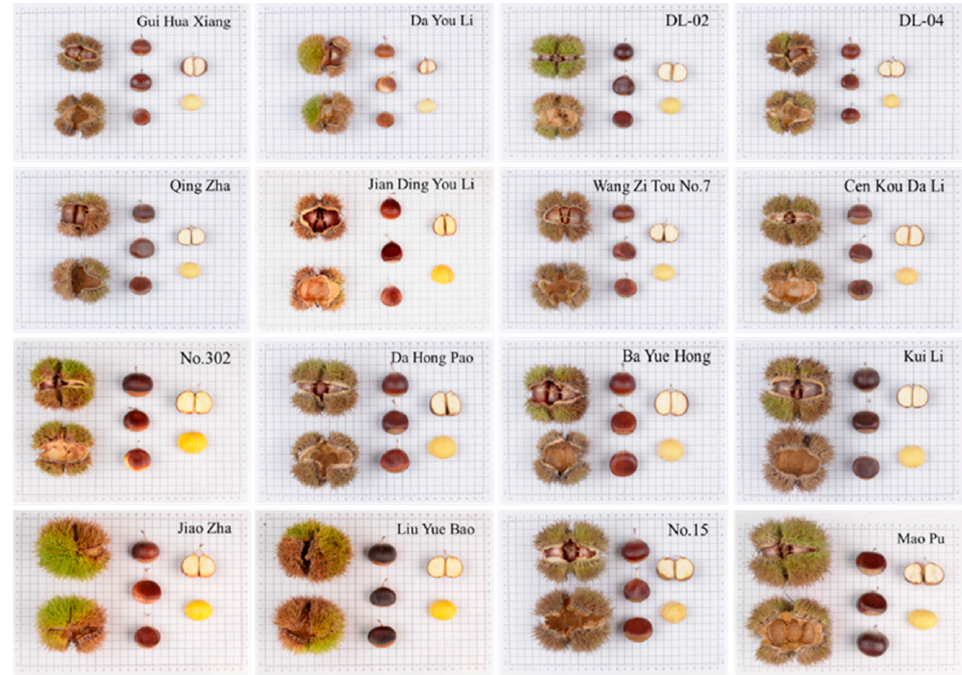
Figure 1. Cluster analysis of phenotypic traits in 118 materials. The labels in the fi gure represent the material number (corresponding to Table S4).